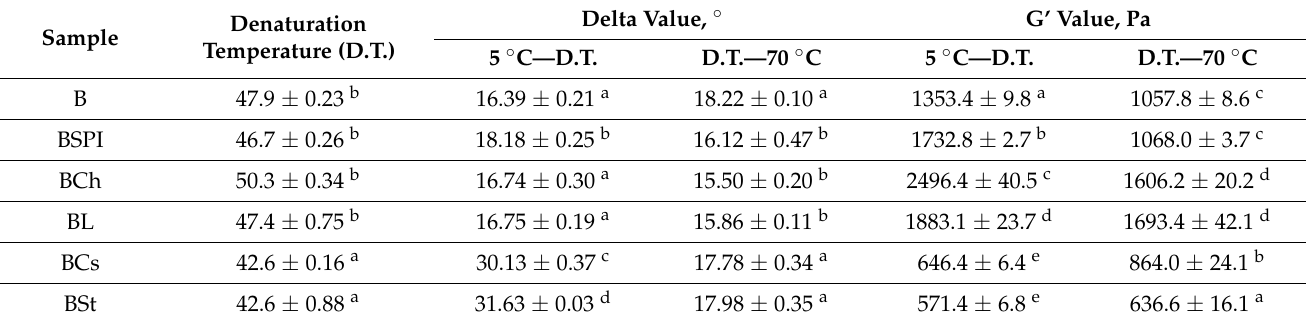
Table 2. Some rheological parameters shown by beef emulsions supplemented with different non- meat